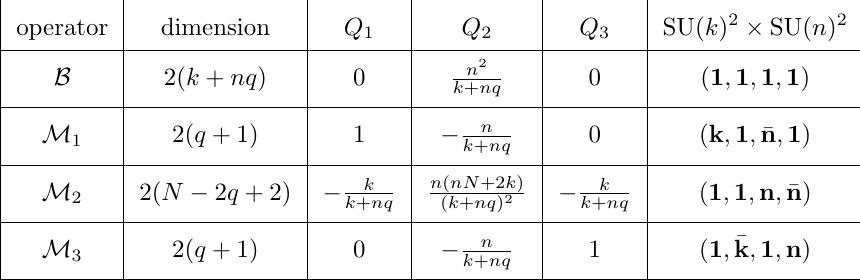
Table 3 . Spectrum of charged BPS operators in the symmetric quiver.